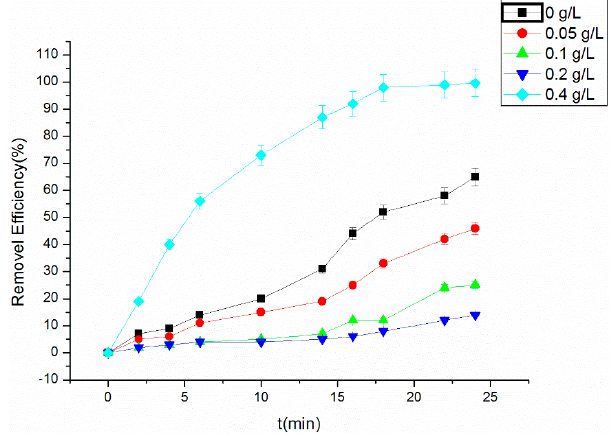
Figure 7. Effect of tertiary butanol on the RhB removal efficiency.